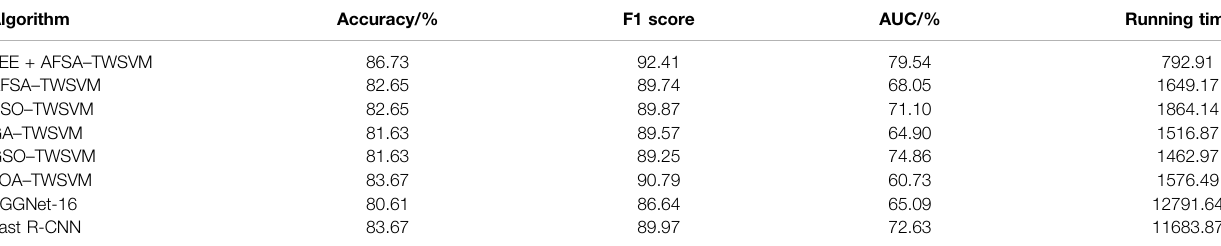
TABLE 2 | Comparison of performance indexes of different